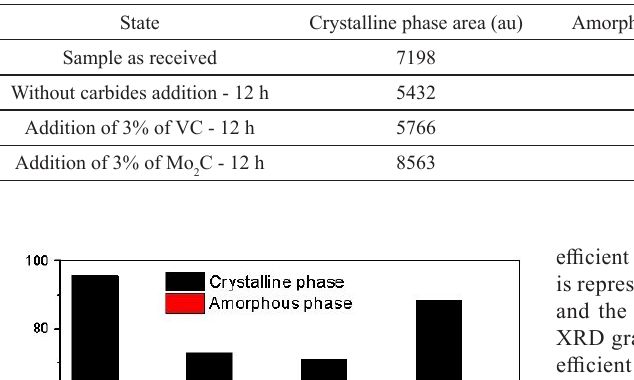
Table 4. Percentages of crystallinity of the Vanadis ® 8 pure and with VC and MO